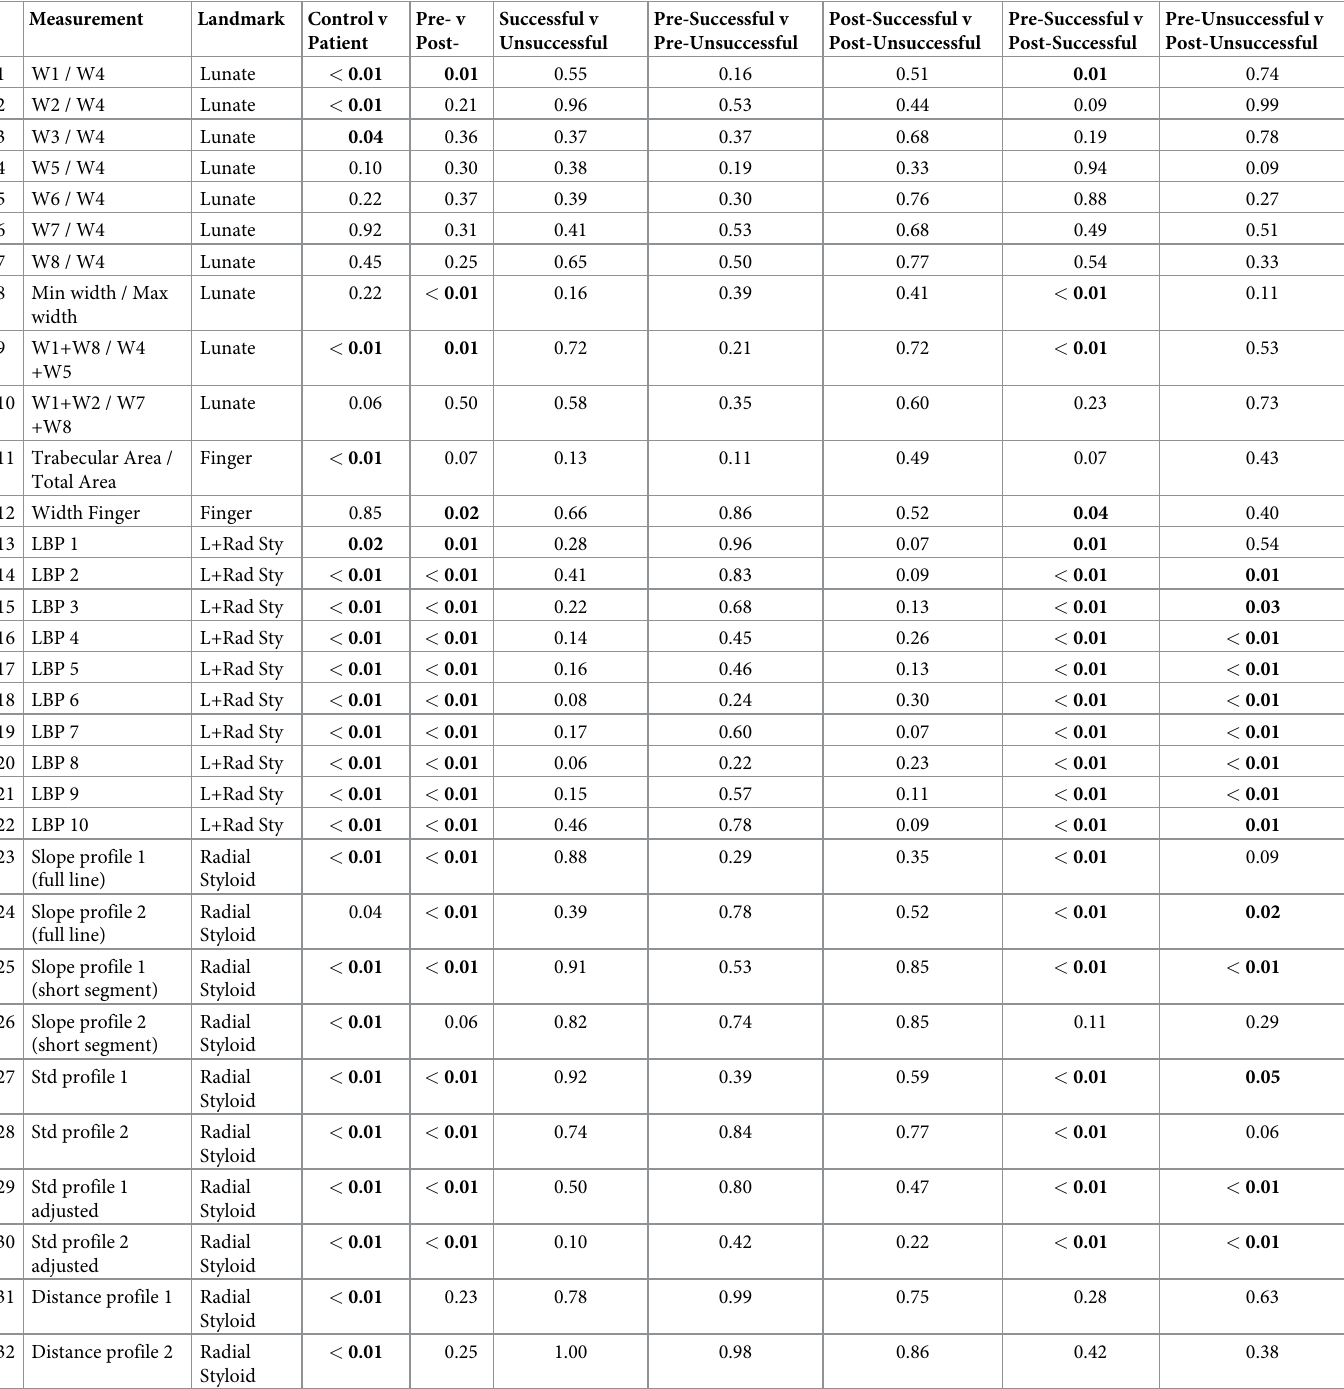
Table 1. Measurements extracted from the radiographs. Third column corresponds to the landmark used to calculate the measurement. Columns 4-10 show the p-values result of paired t-tests between different groups. Values lower than 0.05 are highlighted in bold. Abbreviations: Ratio of width line 1 / width line 4 (W1 / W4), Local Binary Pattern (LBP), Standard Deviation